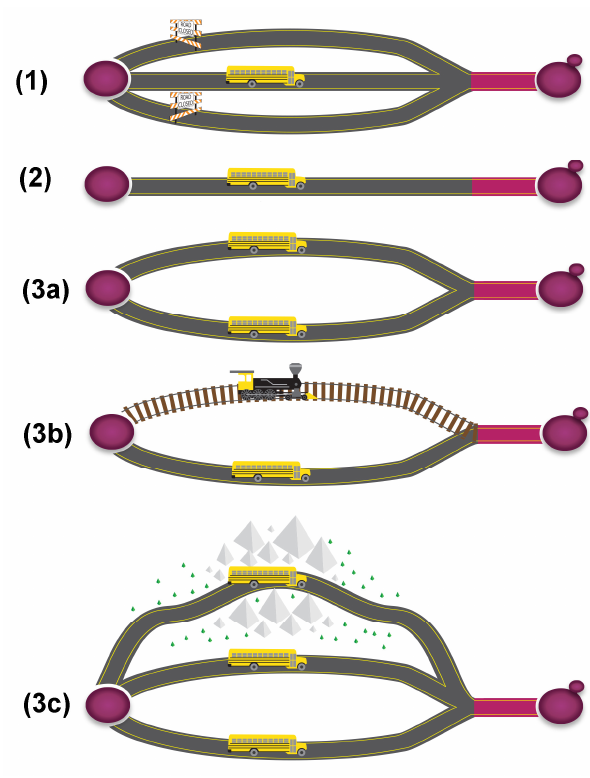
FIGURE 1: A symbolic illustration of different levels of essentiality of the Saccharomyces cerevisiae genes. (1) Conditional essential: when all other roads are closed, this alternative road becomes essential. (2) Essential: the only available road to your